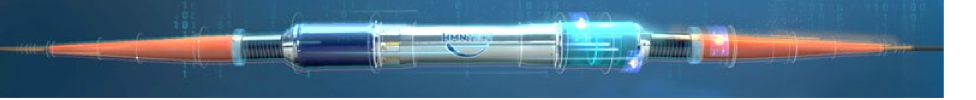
Figure 18. Fifth-generation HMN 1660-32 FP petabit-level optical amplifier (repeater) prototype with a commercial release expected in 2022